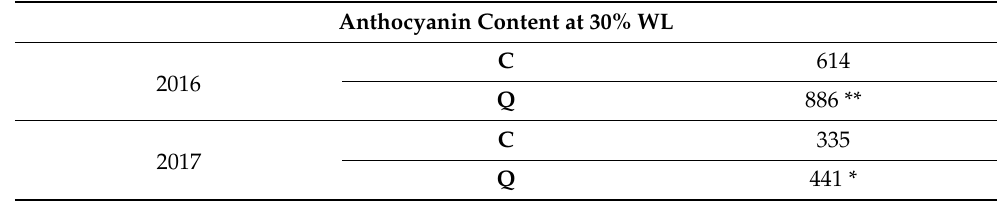
Table 3. Content of anthocyanins in 2016 and 2017, in C (Colombara) and Q (Quaiara). Within rows, *; **; *** values are different at α ≤ 0.05, 0.01, and 0.001. Contents are expressed as mg Kg − 1